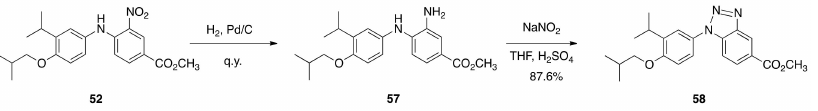
Scheme 4. Synthesis of 58 from 52 .